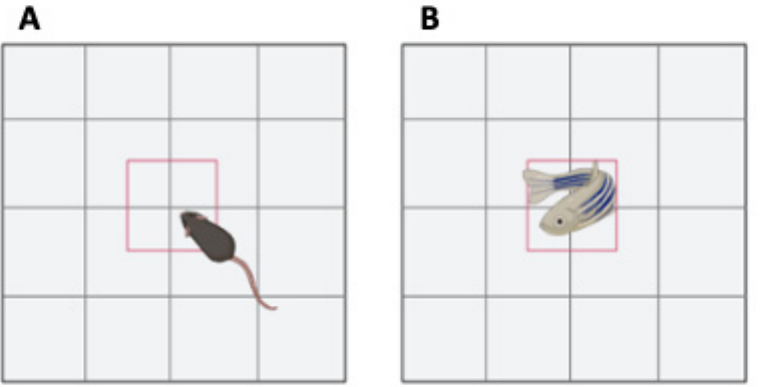
Figure 14. The open field test. ( A ) Test in mice; ( B ) test in zebrafish. An increase in locomotor/exploratory activity is characteristic of ADHD phenotypes. Created with Biorender.com.